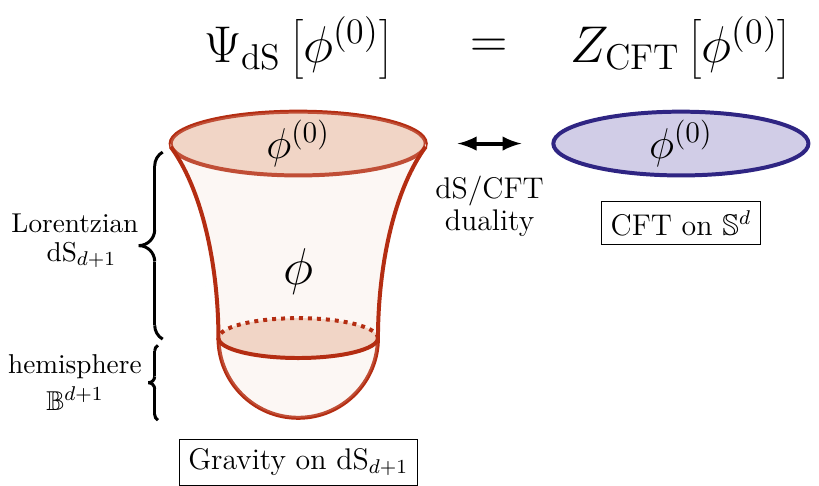
Figure 1 . A sketch of the dS/CFT correspondence. φ denotes all bulk fields and φ (0) does their values at the asymptotic boundary (i.e. future